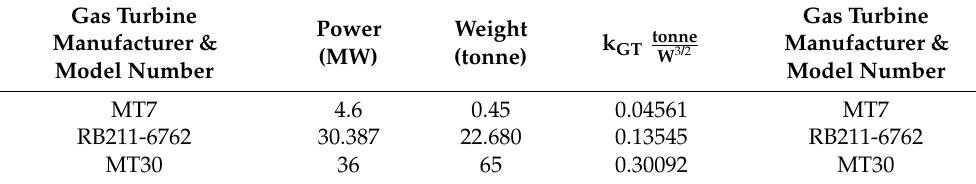
Table 6. Commercially available gas turbine weights.